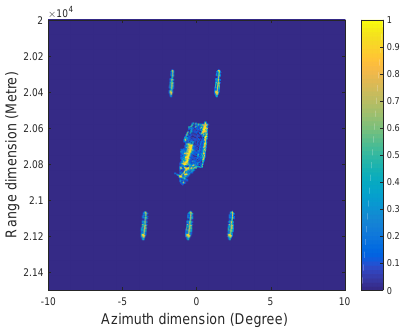
Figure 3. The two-dimensional